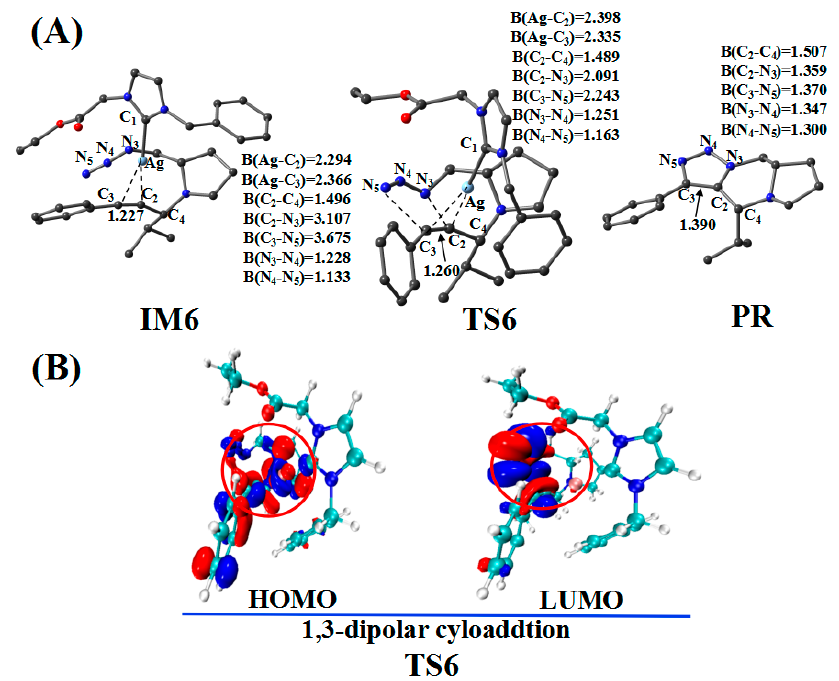
Figure 10. ( A ) Optimized geometries for the cycloaddition reaction; the critical bond length is in Å. Hydrogen atom has been omitted for clarity. ( B ) Frontier orbitals of TS6.